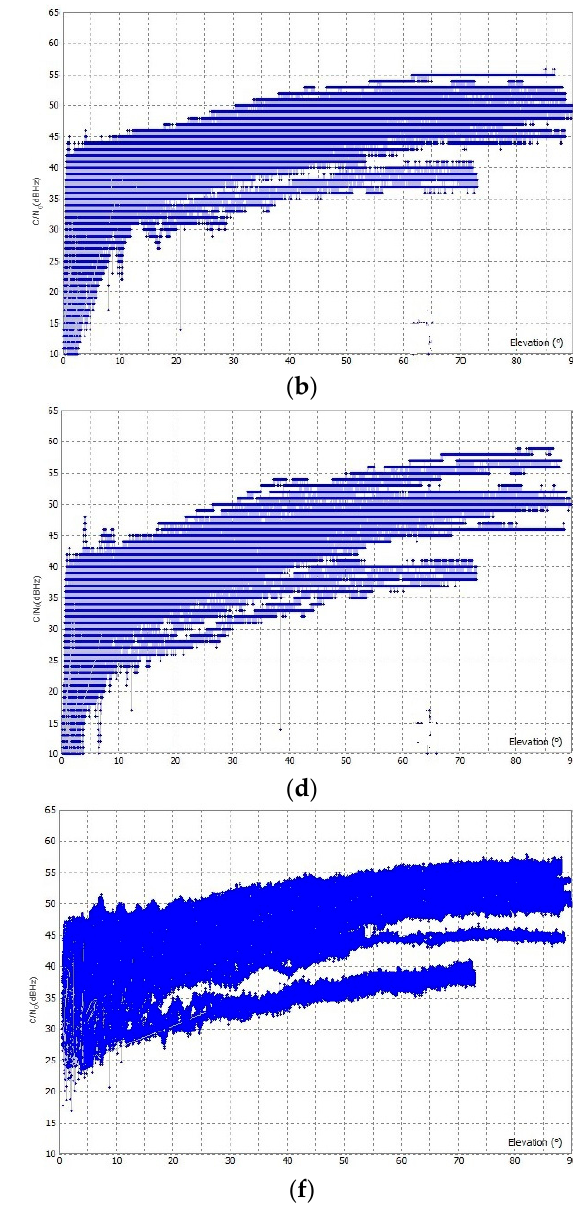
Figure 4. C/N 0 for observations in F1 and F2 frequency in the open sky: ( a ) F1 C/N 0 for LC − 1, ( b ) F2 C/N 0 for LC − 1, ( c ) F1 C/N 0 for LC − 2, ( d ) F2 C/N 0 for LC − 2, ( e ) F1 C/N 0 for GD − 1, and ( f ) F2 C/N 0 for GD − 1.